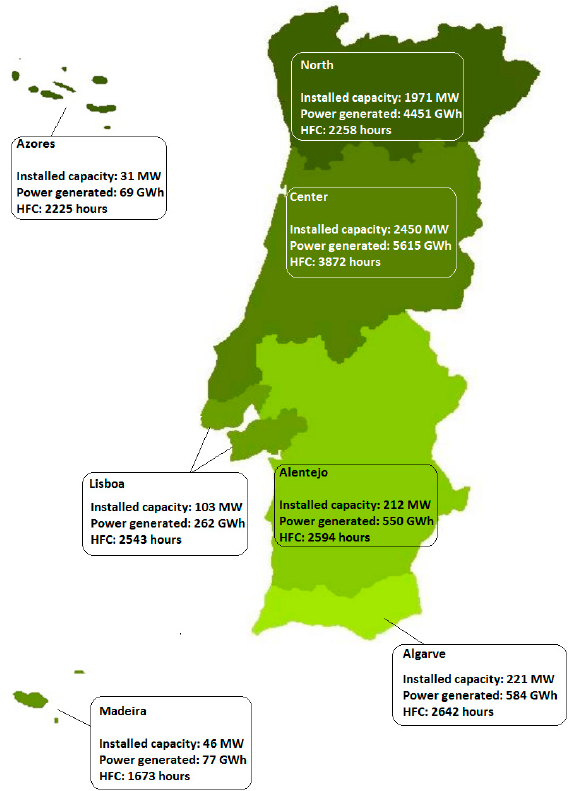
Figure 8. Wind power installed capacity, generation, and annual equivalent hours at full capacity (HFC) for the year 2015 (data taken from [3]).